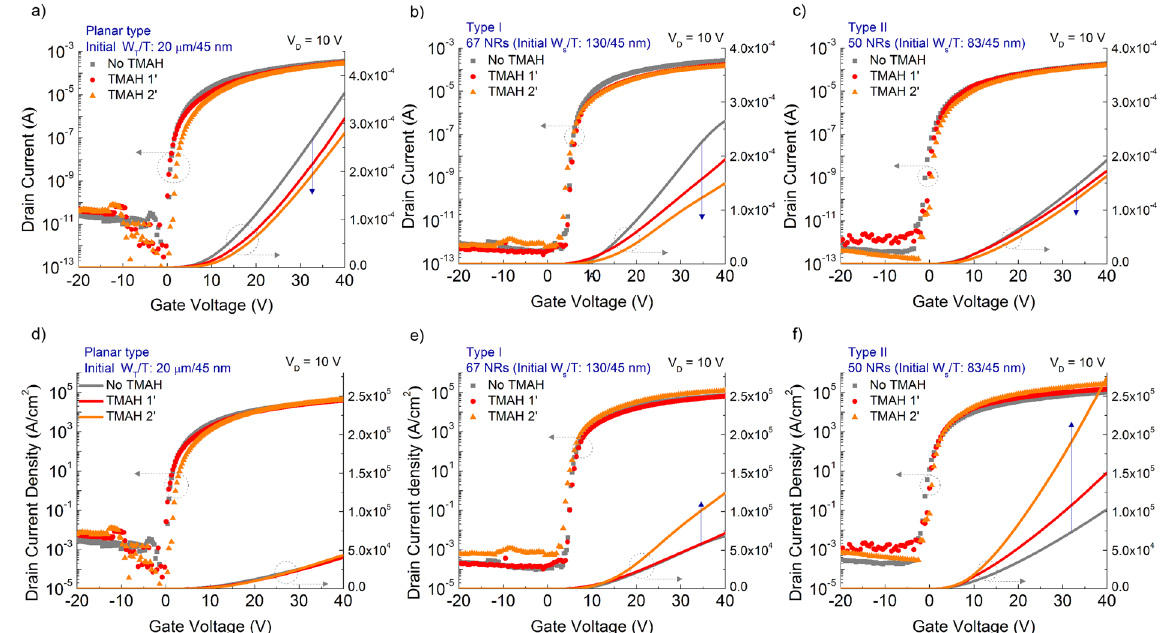
Figure 5. Representative transfer curves of ( a ) planar and ( b , c ) NR TFTs on Si substrate with respect to TMAH etching time. The Y-axis on the right side of each transfer curve shows the linear plot. I D levels decreased with additional etching. Cross-sectional current density of ( d ) planar and ( e , f ) NR TFTs. Cross-sectional I D density was estimated by dividing I D by active area ( W T × T ) of each channel. NR TFTs showed increased current density as NRs shrank, but the planar film TFTs did